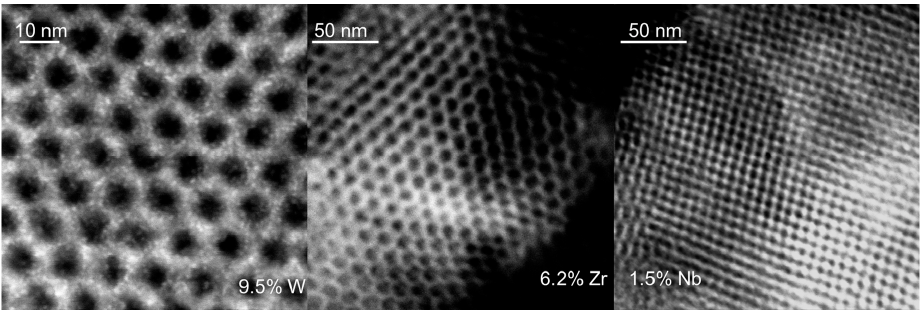
Figure 3. Representative STEM images of M-KIT-6 confirming ordered structure with highly-dispersed MOx species.